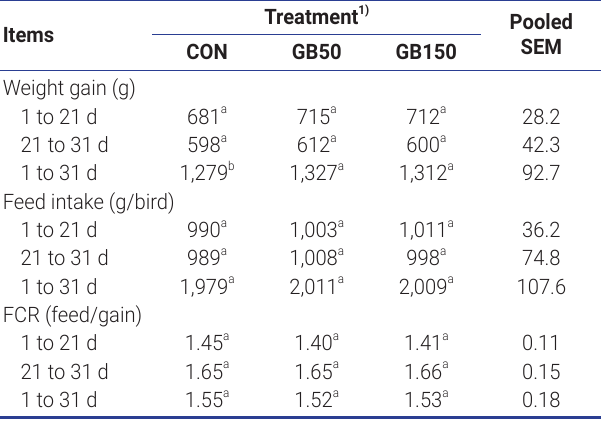
Table 3. Growth performance, feed intake and feed conversion ratio of broiler chickens in heat stress environment (Trial 2) Treatment 1) Pooled Items